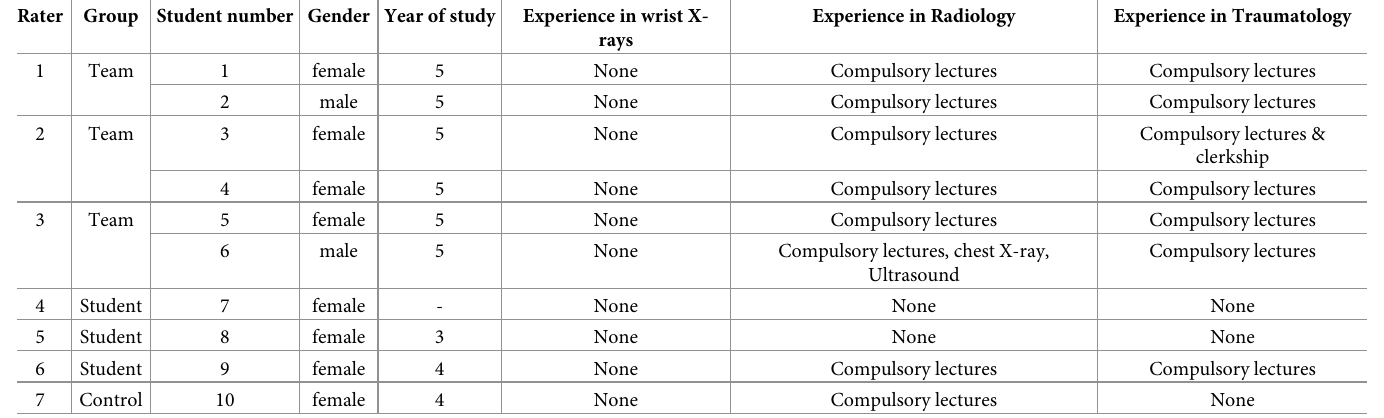
Table 1. Age, sex, study duration, experience with radiography, traumatology, radiology. Rater Group Student number Gender Year of study Experience in wrist X-